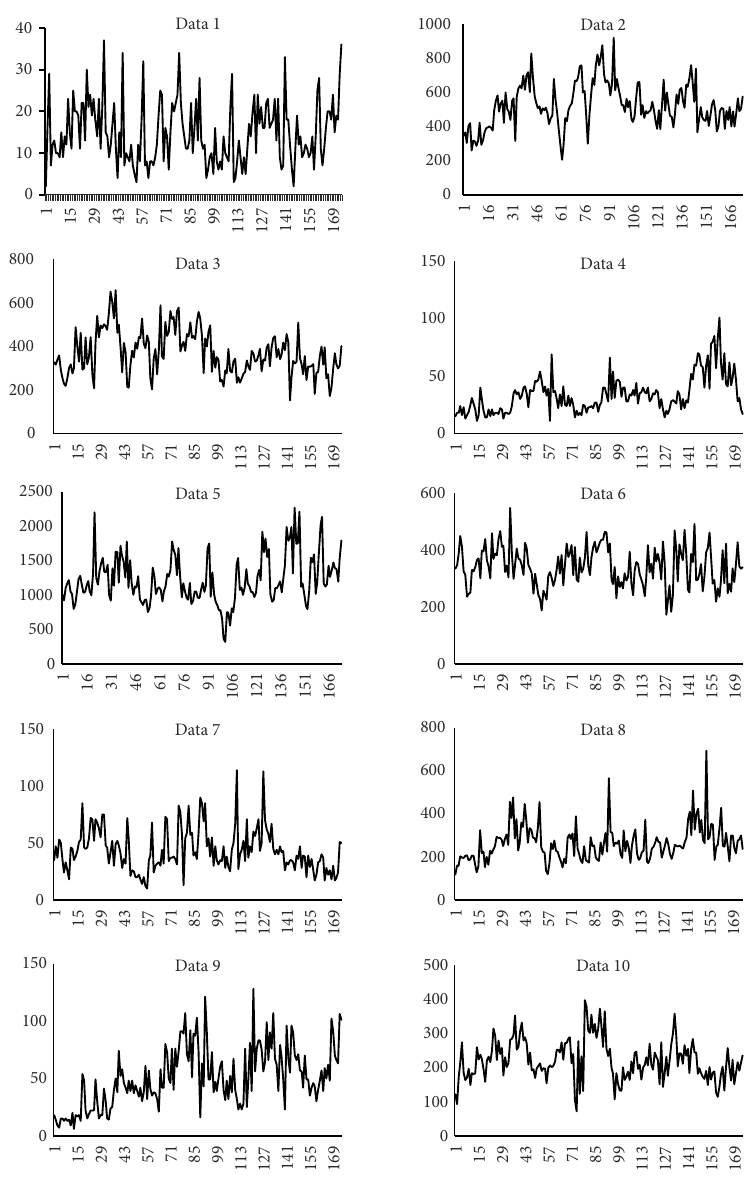
Fig. 2. Time plots of the